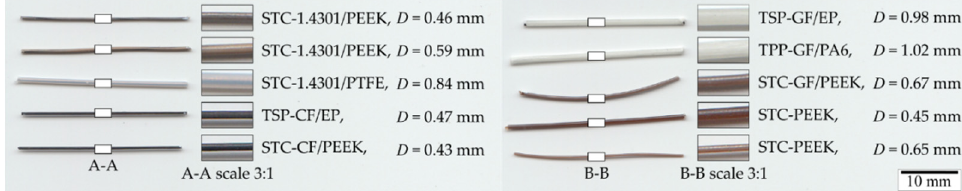
Figure 6. Selection of investigated specimens. Abbreviation: carbon fibre (CF), epoxy resin (EP), glass fibre (GF), shrink tube consolidation (STC), thermoplastic pultrusion (TPP), thermoset pultrusion (TSP), polyamide (PA), polyether ether ketone (PEEK), polytetrafluoroethylene (PTFE). The detail views A-A and B-B of the different specimens were visualised with a triple magnification.